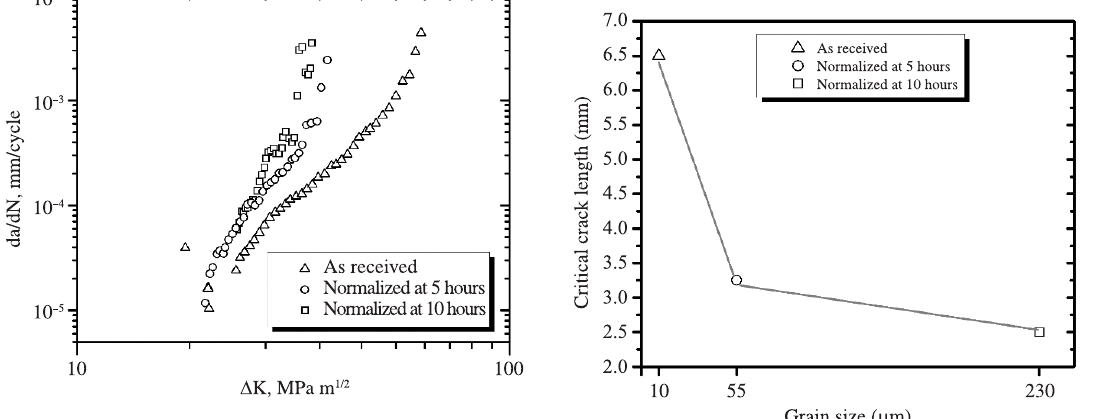
Figure 2. Plot of crack growth rate behaviour with the stress intensity factor for the HAZ normalized at 1200 °C for different time periods.